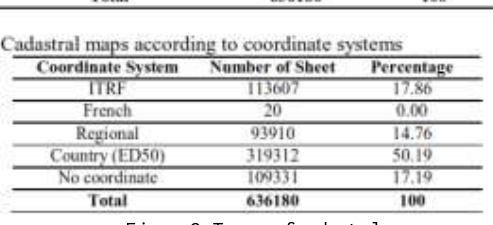
Figure 2. Types of cadastral maps